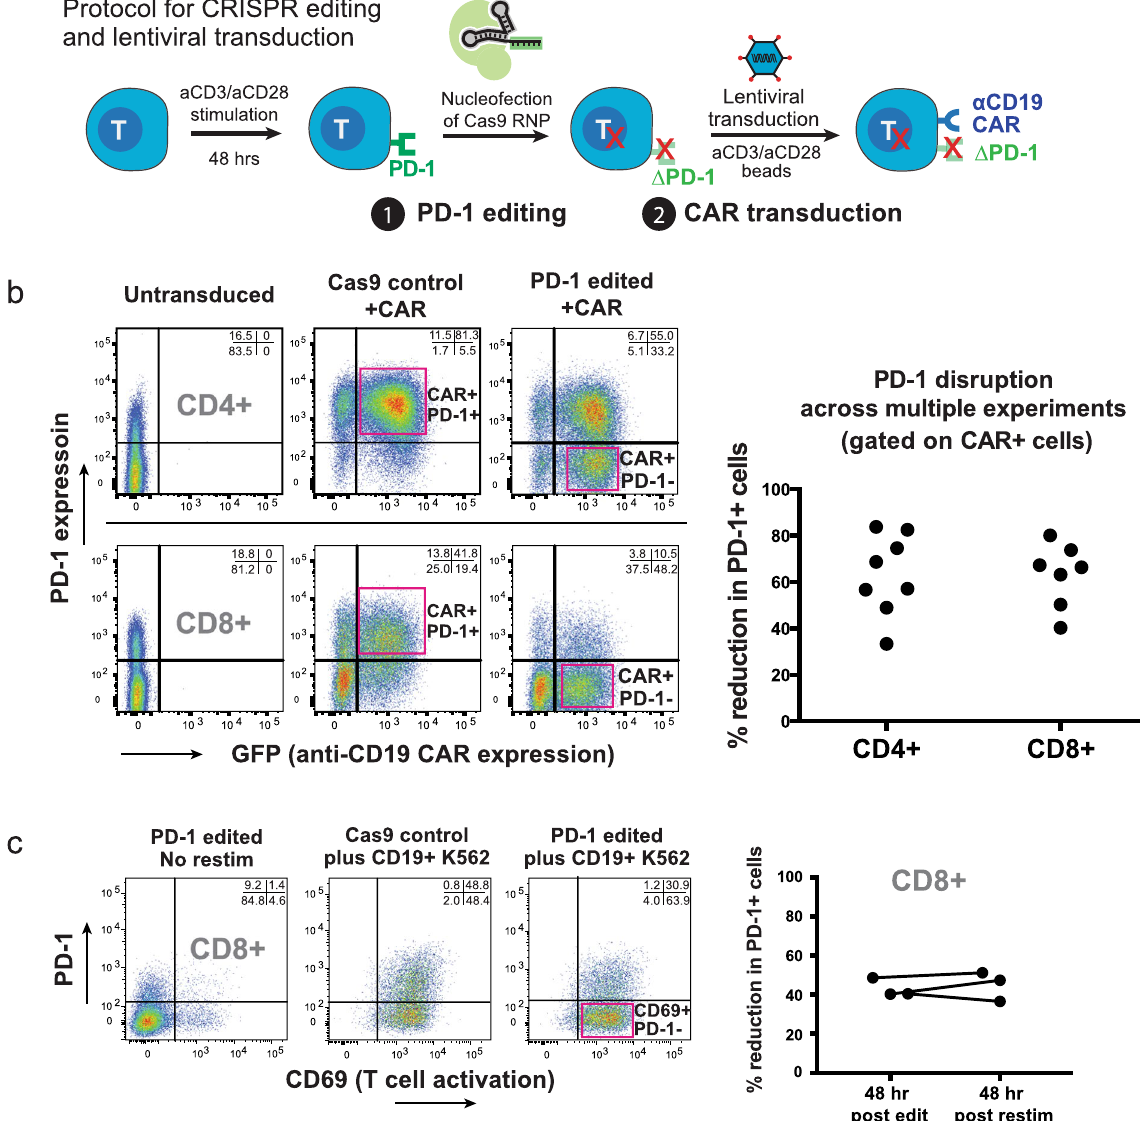
( b ) Efficient PD-1 deletion and CAR transduction in primary human T cells. PD-1 surface staining and CAR transduction were assessed 48 hours post editing. A > 50% reduction in PD-1 + cells was routinely observed, with CAR transduction > 70%. Right panel, individual dots represent independent editing experiments. ( c ) PD-1 edited CAR T cells are stable in culture. Resting PD-1 edited CD8 + anti-CD19 CAR T cells were re- stimulated with CD19 + K562 cells. Activation was measured by CD69 induction and percent reduction in PD-1 + cells measured by flow cytometry based on surface PD-1 expression; percent reduction of PD-1 + cells was similar to that observed 48 hours after editing (rightmost panel, pairwise